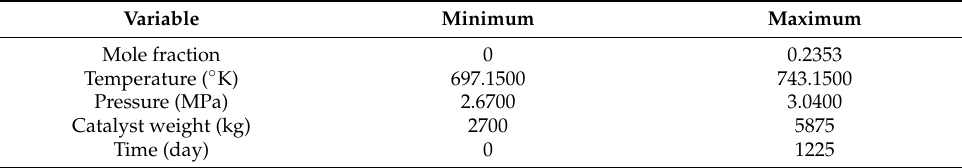
Table 4. Range of ANN model